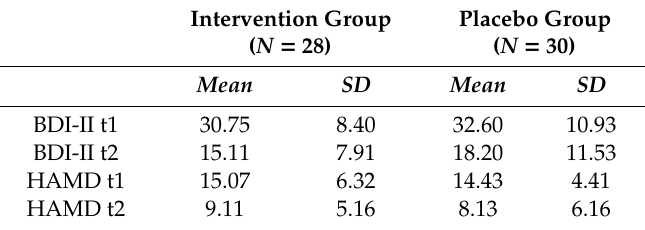
Table 3. Mean values and standard deviations in depression scores.